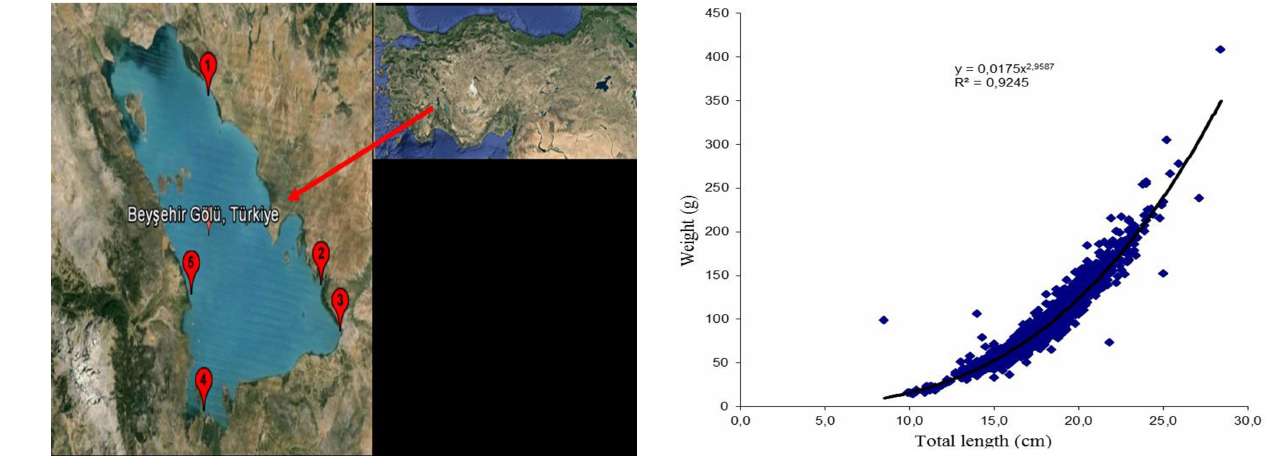
Fig. 2. Length-weight relationship of C.